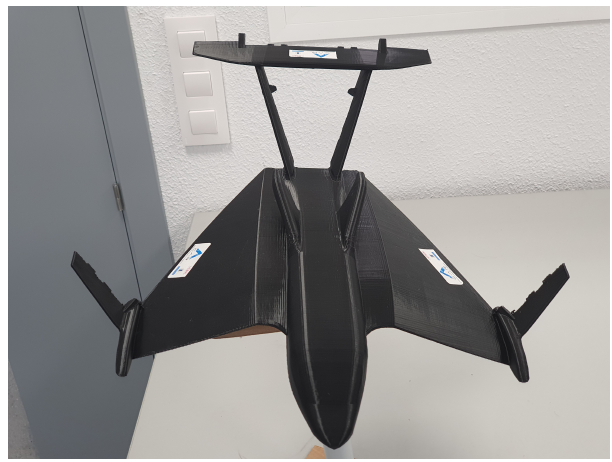
Figure 3. Physical model for wind tunnel and motion capture